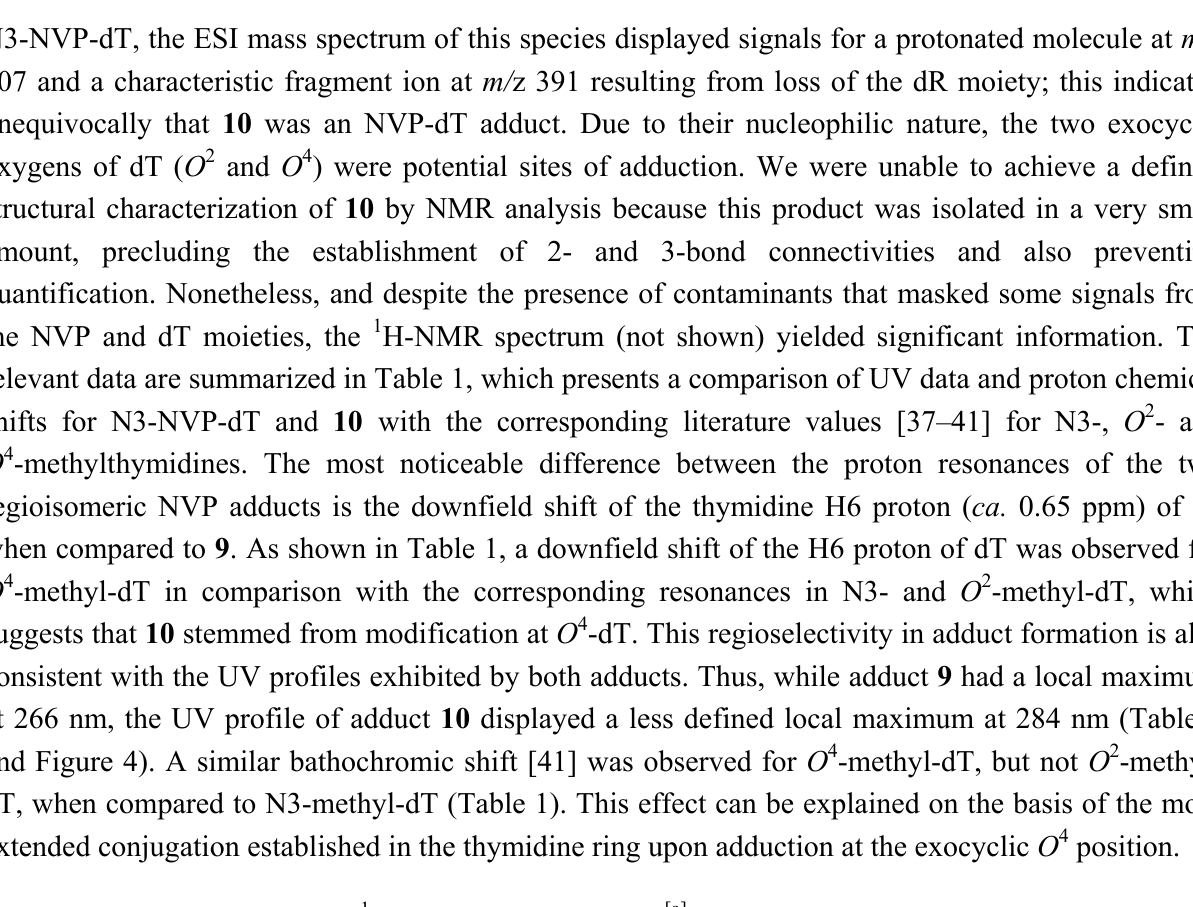
Table 1. Comparison of 1 H-NMR dT resonances [a] and UV maxima in adducts 9 and 10 with literature data for